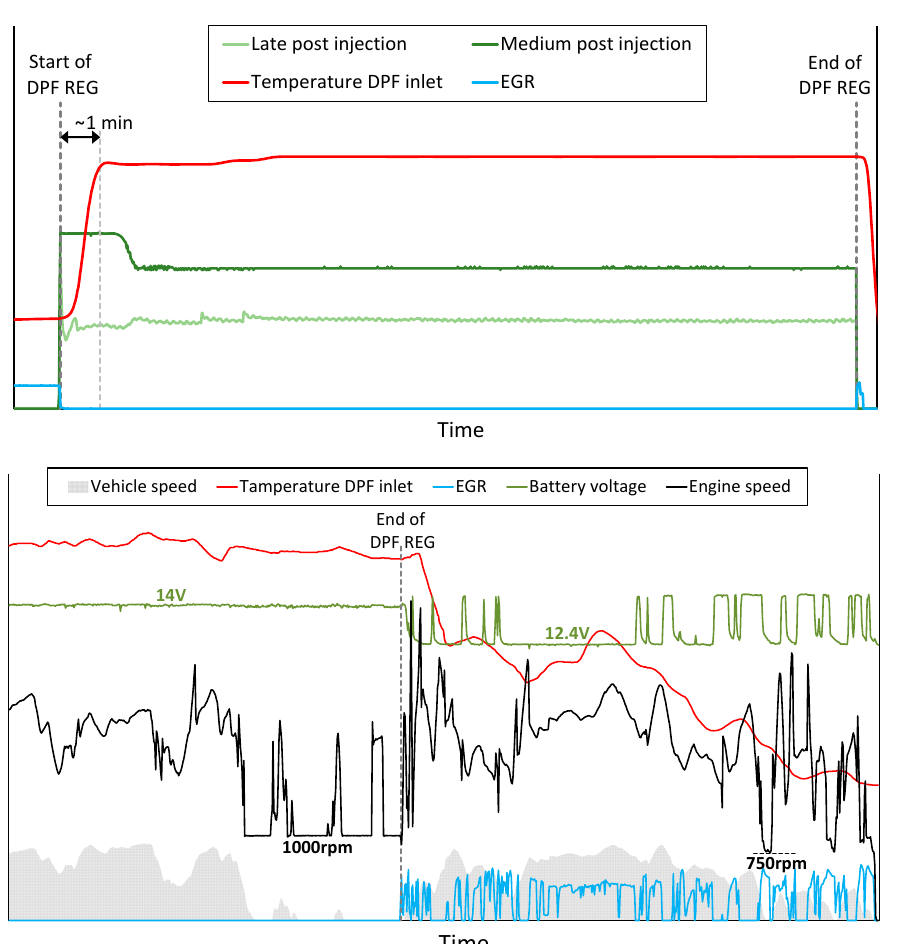
Figure 2. Identification of active DPF regeneration with detailed ECU and OBD data, ( top ): injection strategy during regeneration at steady-state operation, ( bottom ): engine and vehicle parameters during on-road driving with regeneration.